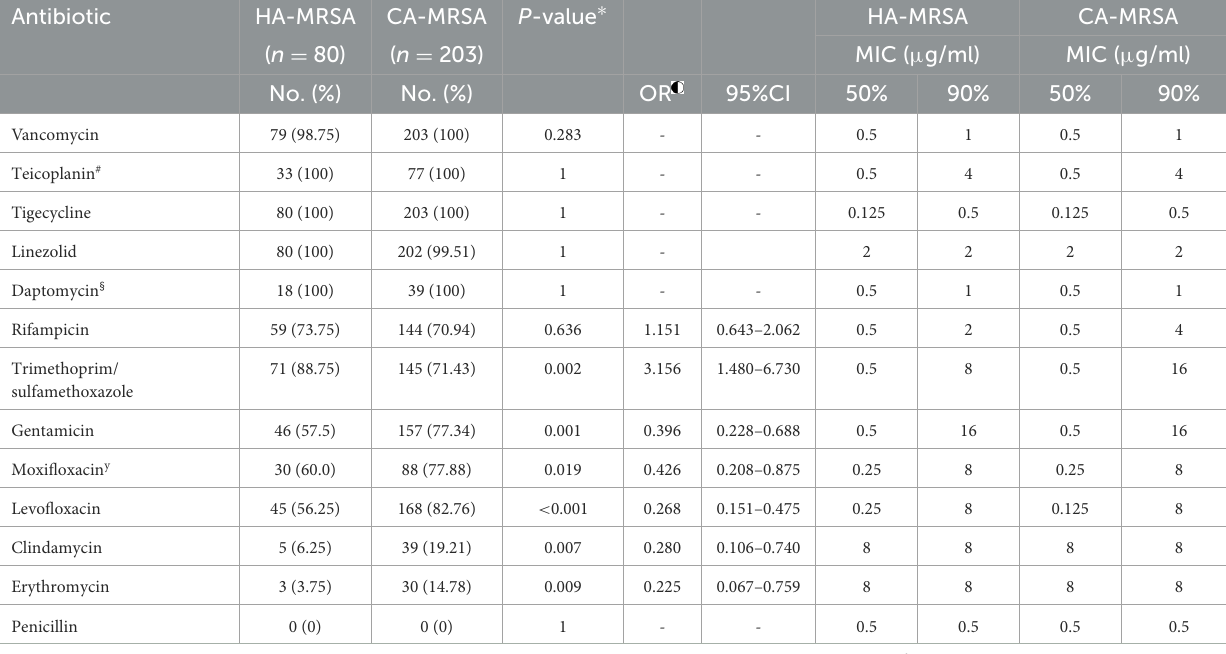
TABLE 4 Antibiotic susceptibility and MICs of skin and soft tissue healthcare-associated methicillin-resistant S. aureus (HA-MRSA) and community-associated methicillin-resistant S. aureus (CA-MRSA) isolates from January 1, 2015 to December 31, 2021.